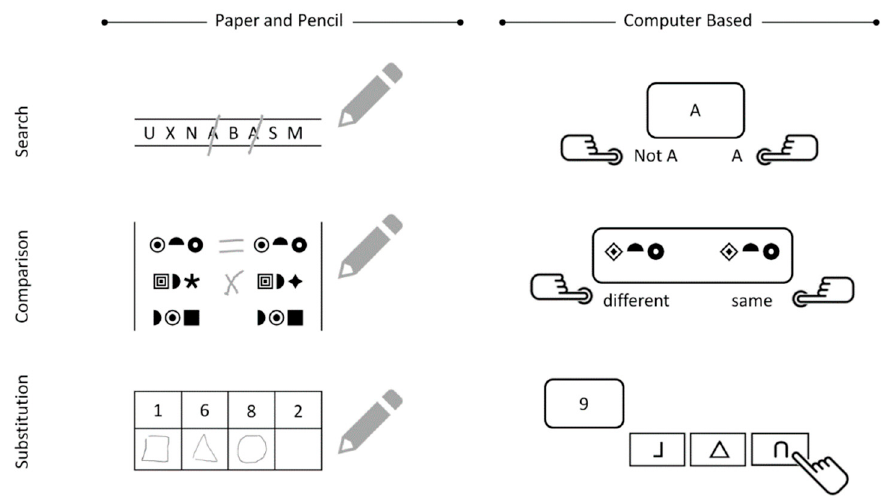
Figure 1. Examples of paper-and-pencil and computer-based mental speed tests.